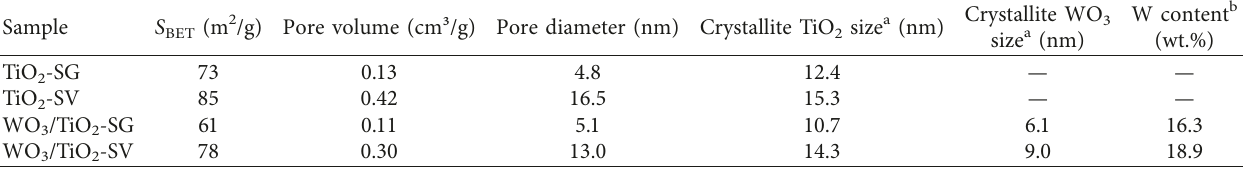
Table 1: Physical properties of TiO